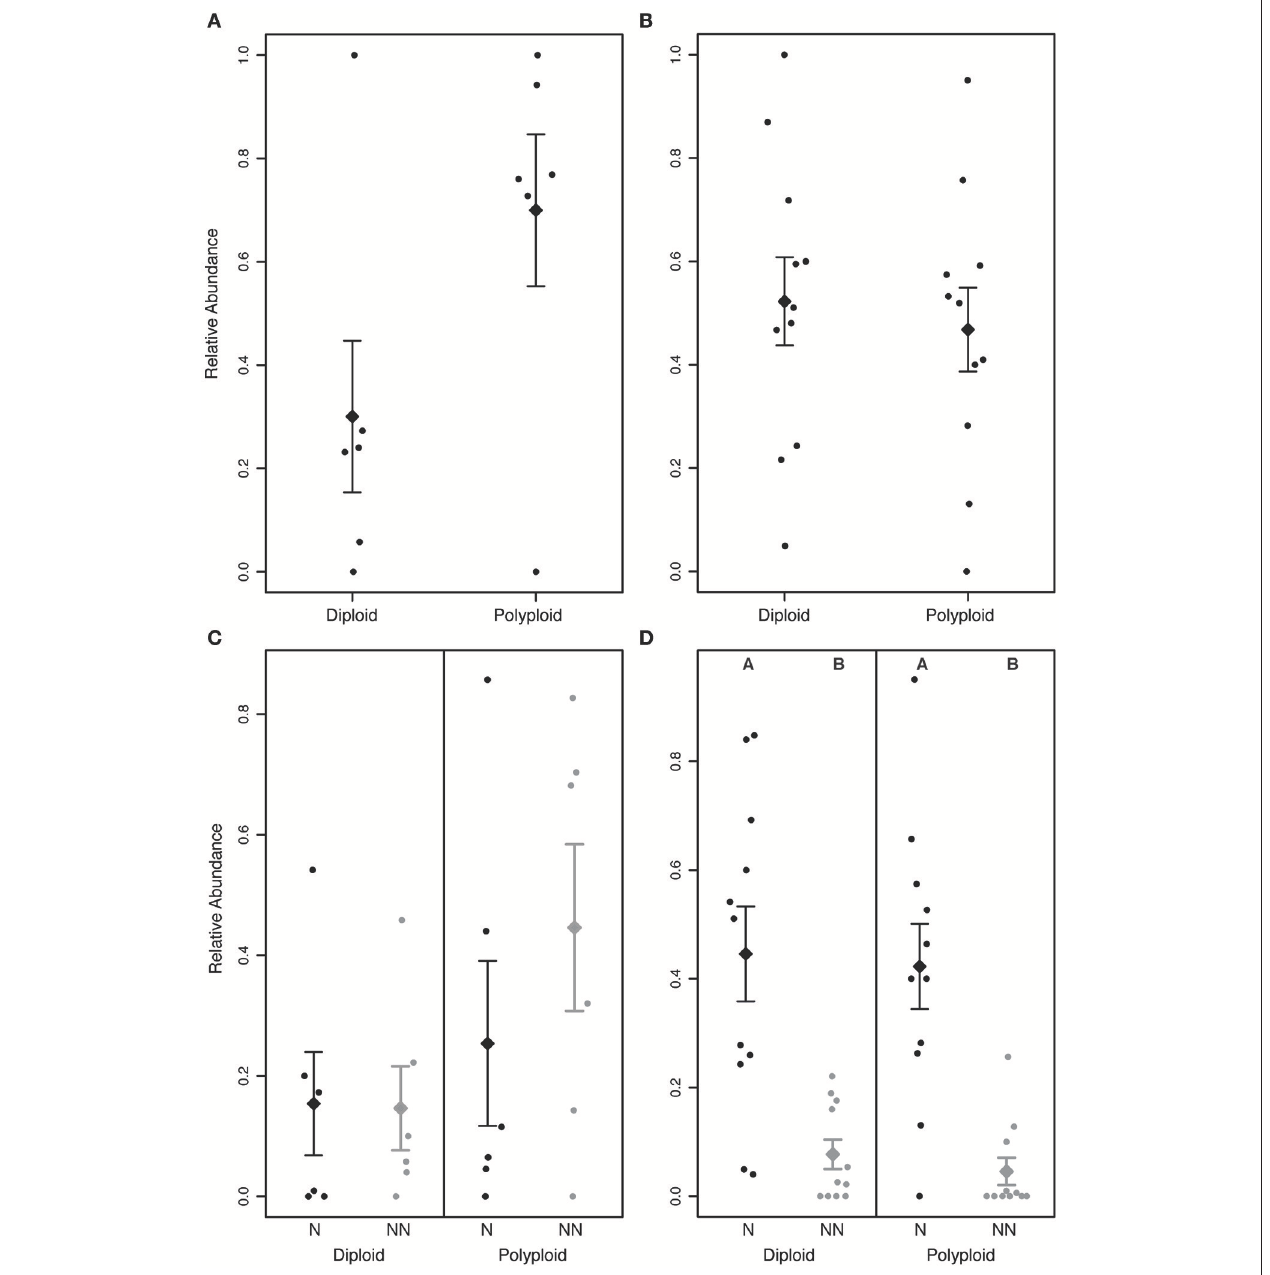
FIGURE 5 | Relative abundance of diploids and polyploids in (A,C) Brassicaceae and (B,D) Rosaceae communities. (A) In Brassicaceae communities, polyploids tend to be more abundant than diploids, though the difference was not significant ( P > 0.05). (B) In Rosaceae communities, diploids and polyploids do not significantly differ in abundance (P > 0.05). (C) In Brassicaceae communities, non-native (NN) polyploids tend to occur at a greater abundance than the other groups, but the difference is not significant ( P > 0.05). (D) In Rosaceae communities, native species (N) are significantly more abundant than non-native species for both diploid and polyploid species ( P < 0.05). Letters above the distributions in (D) indicate significantly different groups. The diamond and error bars indicate the mean of the distribution ± 1 standard